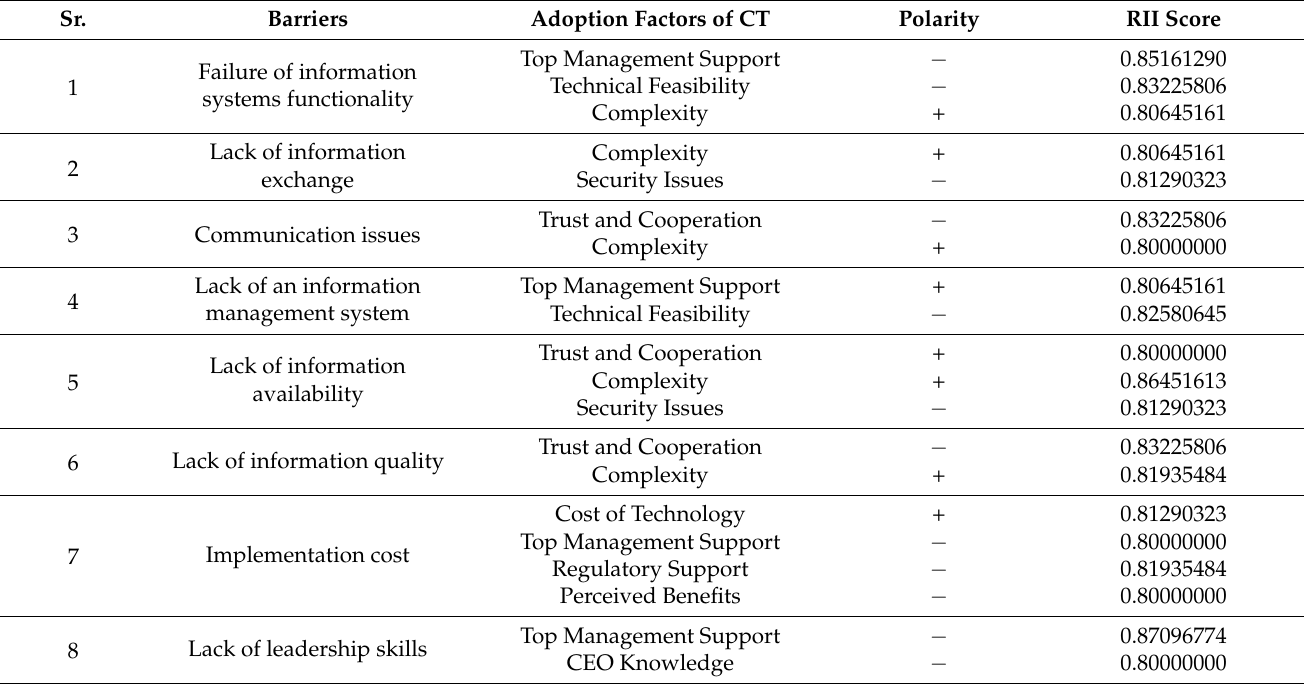
Table 5. Shortlisted barriers and